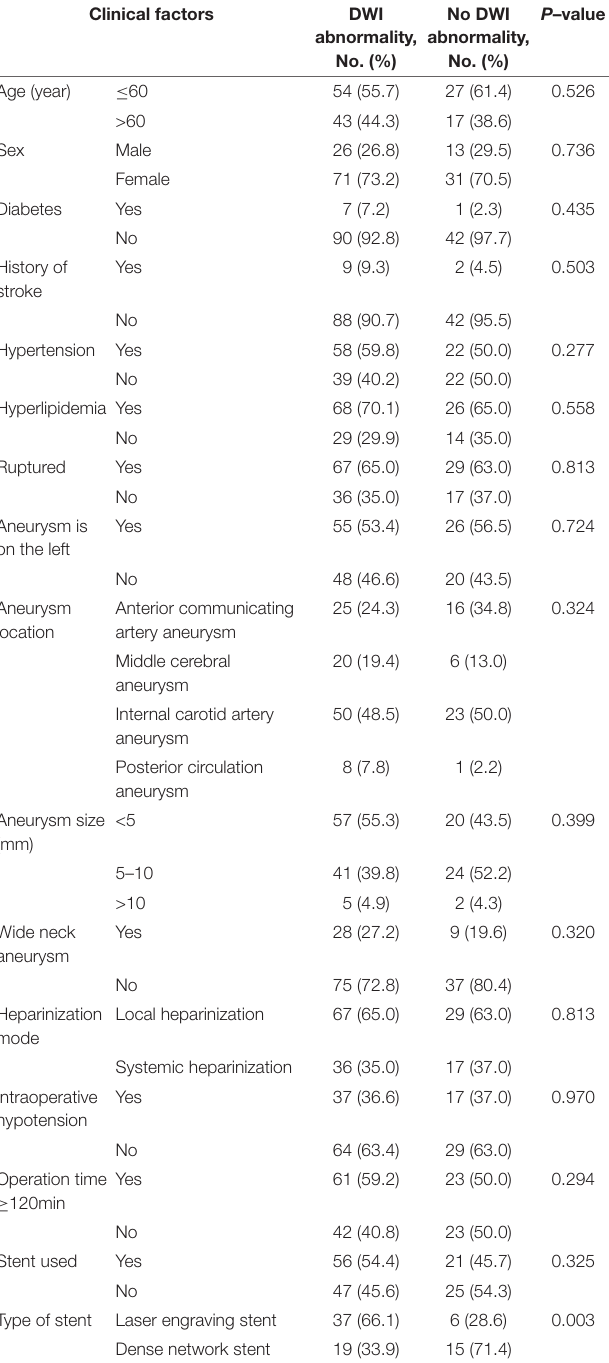
TABLE 5 | Multivariate analysis results of clinical data. Clinical